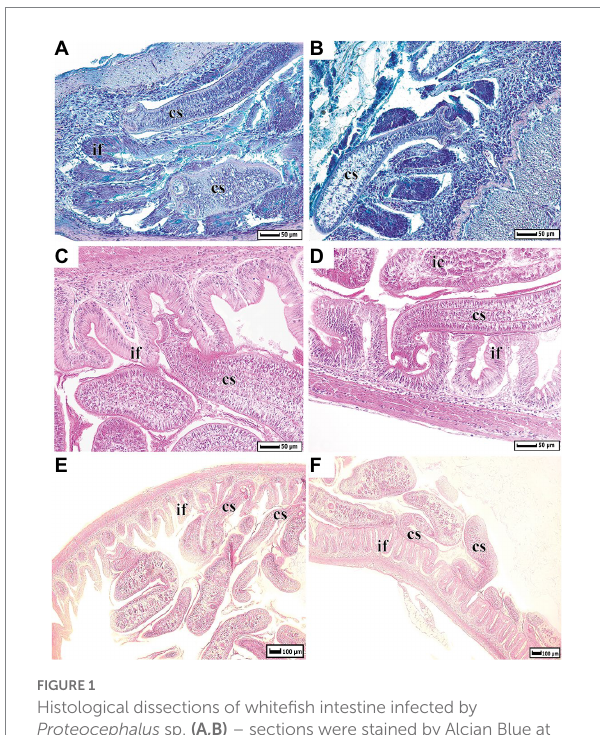
FIGURE 2 SEM and TEM observation of Proteocephalus sp. surface before (A,B,D) and after (C,E,F) Triton X-100 desorption. (A,B) SEM view of arrangement of filamentous microtriches on strobila surface. (C) SEM view of smooth surface of strobila. (D) TEM view of the tegument showing distal syncytial cytoplasm covered with microtriches and supported by basal lamina and fibrillar extracellular layer. (E) SEM view of the surface losing distal syncytial cytoplasm, note places of the connection of distal cytoplasm with sunken perikarya. (F) TEM of a portion of the tegument losing distal cytoplasm with microtriches, note basal lamina with fibrillar extracellular layer along the border of the tapeworm. bl, basal lamina; cb, cylindrical base of microtriches; dc, distal syncytial cytoplasm; ds, distal shaft of microtiches; em, extracellular matrix; fm, filamentous microtriches; mf, muscle fibers; p, pores; sm, spiniform microtriches; ss, smooth surface.